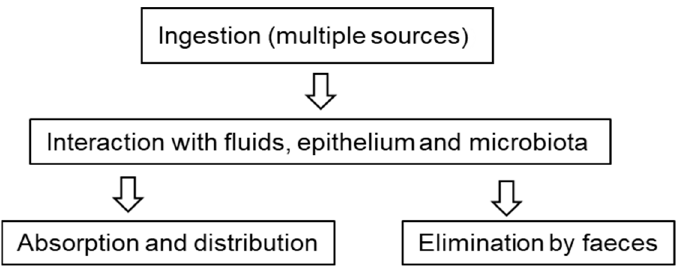
Figure 2. Oral exposure to microplastics. Possible routes and interactions that are currently under study. Recent research suggests that, depending on the size, particles can be internalized by intestinal epithelial cells (endocytosis) or they can pass between intestinal cells (para- cellular transport) [46]. Animal studies have shown the distribution and deposition of MNPLs in organs such as the kidneys, liver, and lymph nodes [47–49]. However, this systemic distribution remains controversial, and further studies are needed to corroborate this